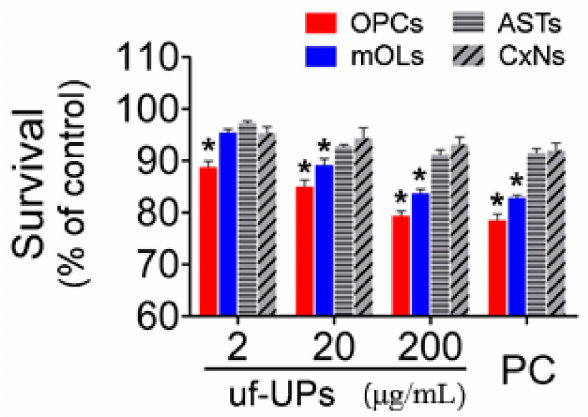
Figure 2. Cell survival analysis using MTT assay. Survival rates of OPCs and mOLs are significantly lower than those of ASTs and CxNs from 2 and 20 µ g/mL uf-UPs, respectively. Hydrogen peroxide (H 2 O 2 , 100 µ m) is used as a positive control (PC). Note that the survival rate of each cell type at 200 µ g/mL uf-UPs is similar to the rate at 100 µ m of hydrogen peroxide. Data are expressed as percentage of the control and represent mean ± SEM ( n = 8). * p < 0.05 vs. ASTs and